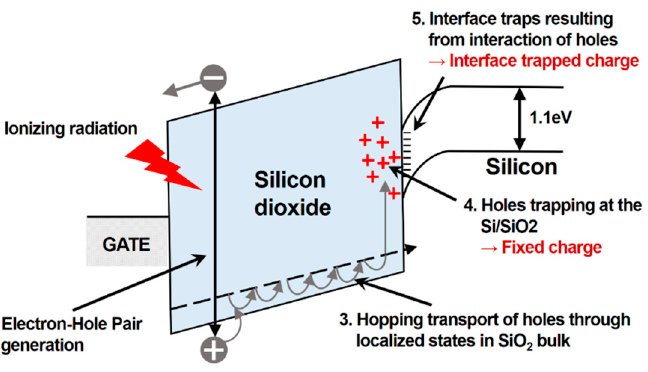
Figure 1. Radiation-induced fixed charges in the n-MOSFET caused by total ionizing dose (TID) effect.